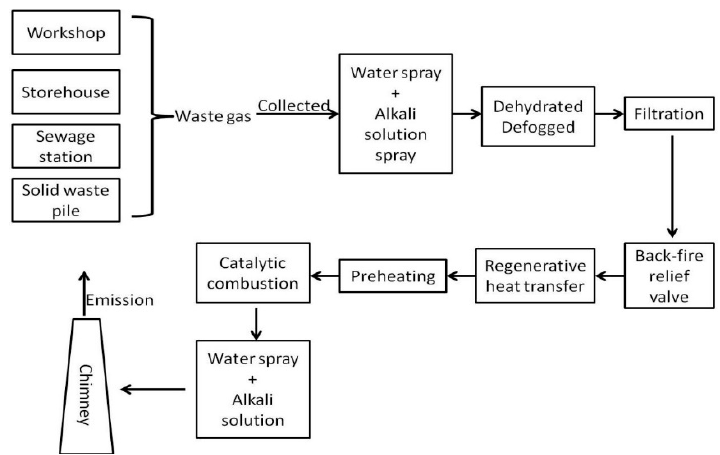
Figure 10. VOCs abatement process in the A factory. Reprinted with permission from [4], 2016, CNKI